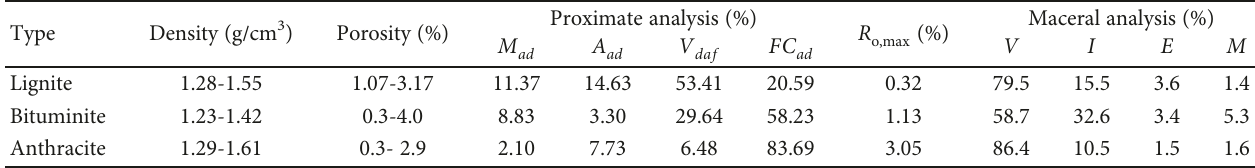
Table 1: Detail properties of the coals with di ff erent ranks.